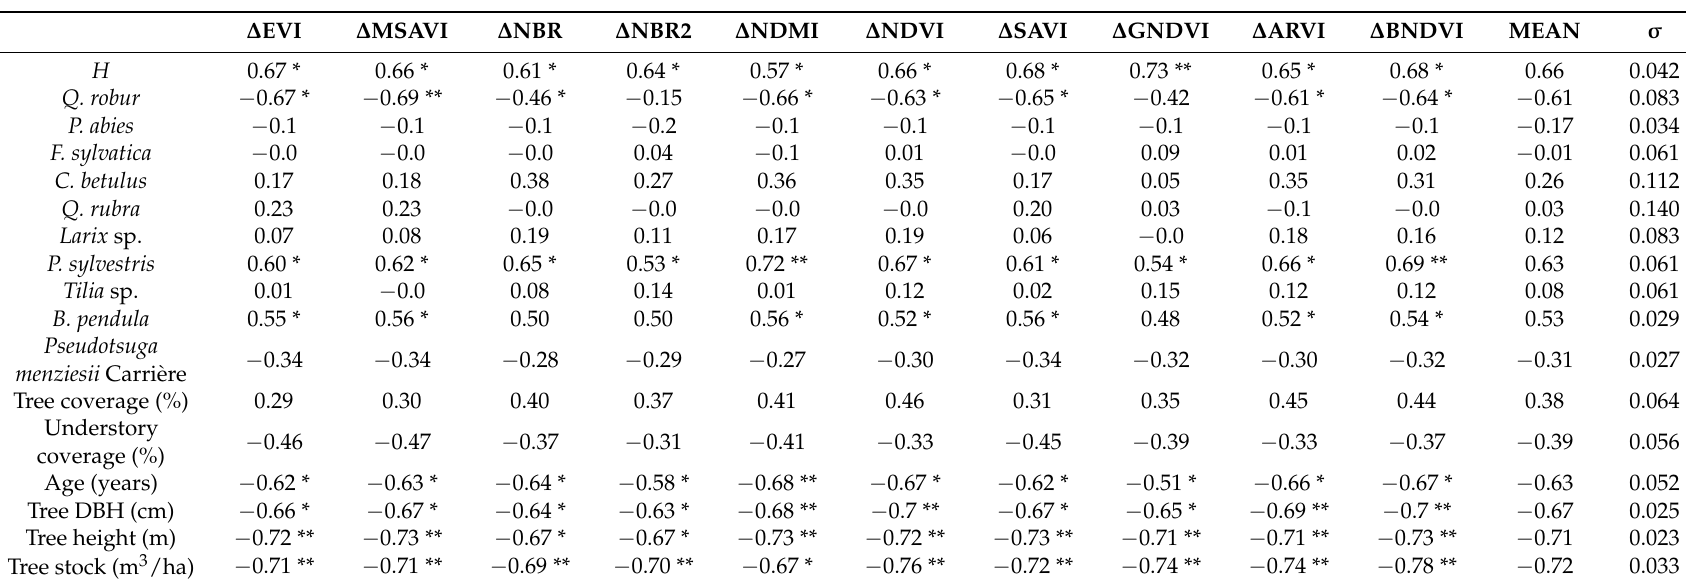
Table 4. Pearson’s coefficient of correlation between vegetation indices differences ( ∆ VIs) and the shares of particular species in forest divisions and for